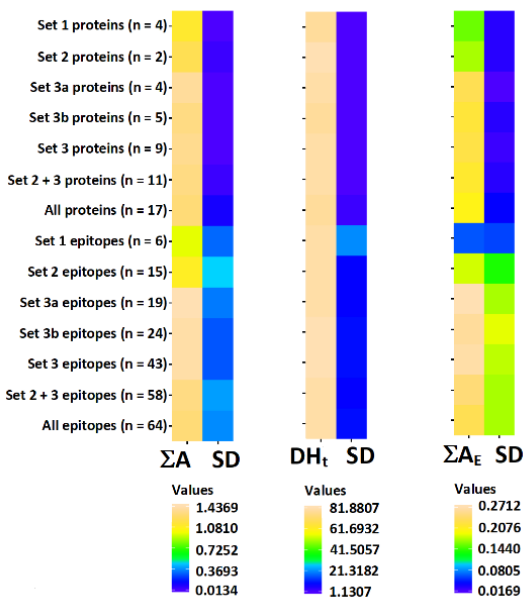
Figure 7. Scores attributed to particular set of domains. ∑ A—total frequency of bioactive fragments occurrence in a protein sequence (Equation (1)); DH t —theoretical degree of hydrolysis (Equation (2)) expressed in %; ∑ A E —total frequency of release of bioactive fragments by proteolytic enzymes (Equation (3)), SD—standard deviation.